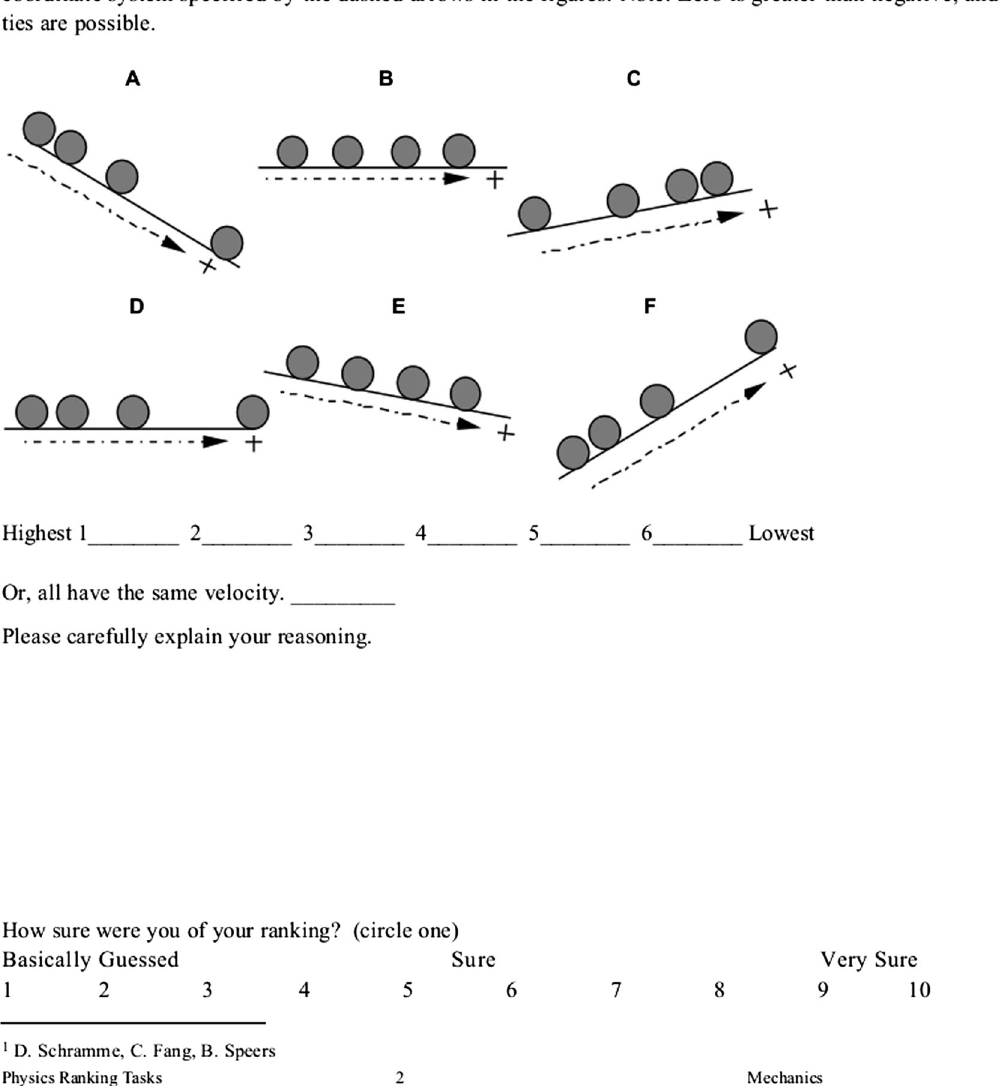
FIG. 5. An example of a ranking task from O ’ Kuma et al. [27]. Data are coded as